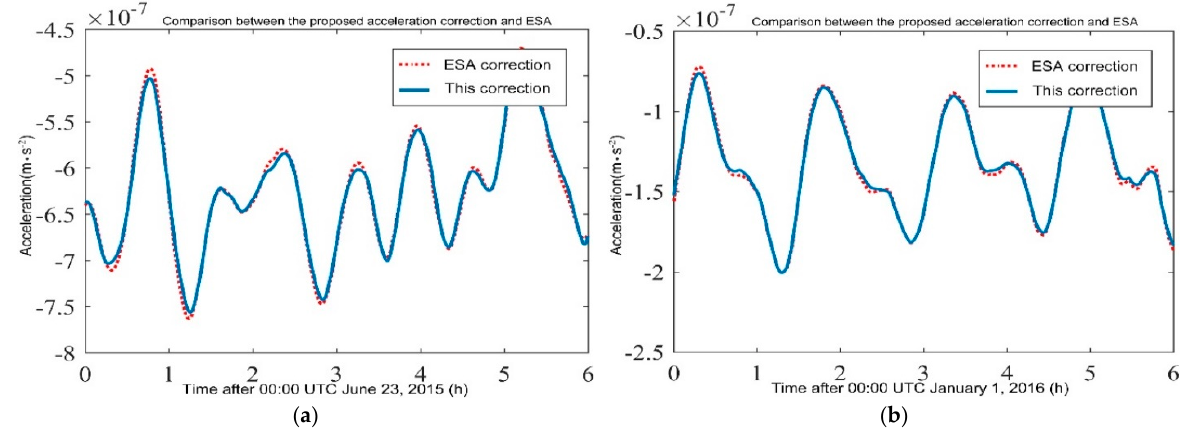
Figure 4. Comparison between accelerometer data correction results and ESA ( a ) during magnetic storm day (Kp = 8, magnetic storm level: G4); ( b ) during nonmagnetic storm day.